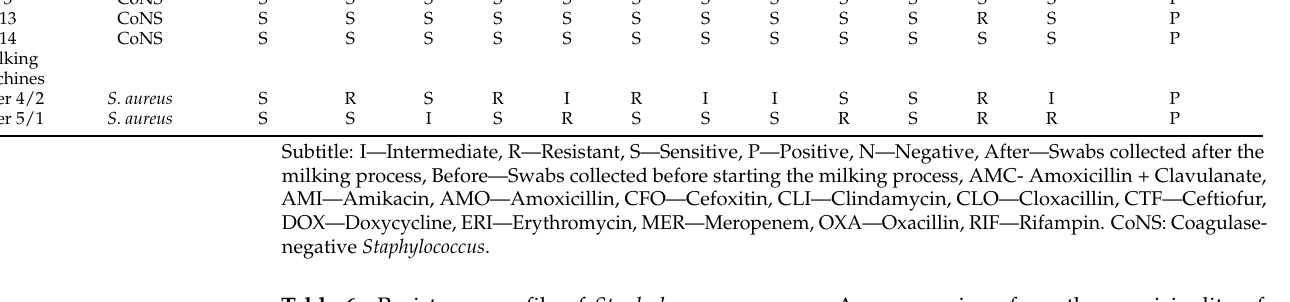
Table 6. Resistance profile of Staphylococcus spp. mec A gene carriers, from the municipality of Tapejara, northwestern Paran á State, Brazil, May–June